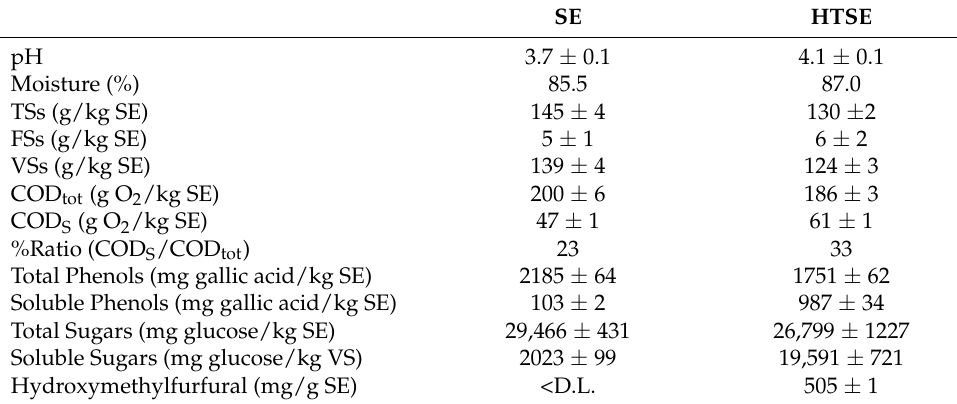
Table 1. Analytical characterisation of the strawberry extrudate and the hydrothermally treated strawberry